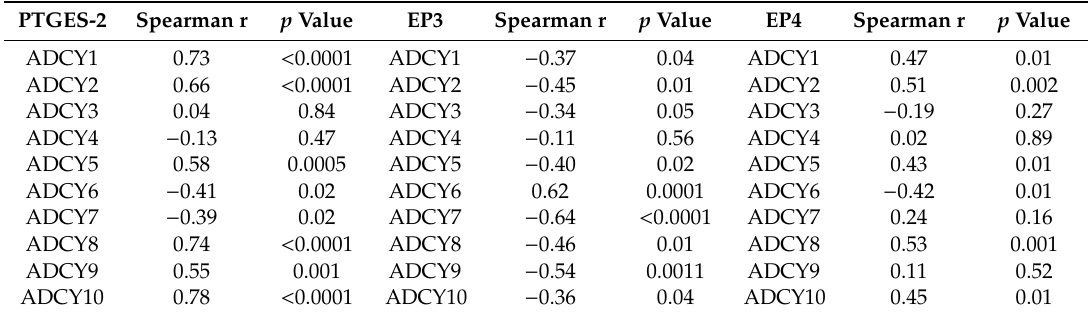
Table 4. EP3, EP4, and PTGES-2 are involved di ff erently in cAMP production in EAT. PTGES-2